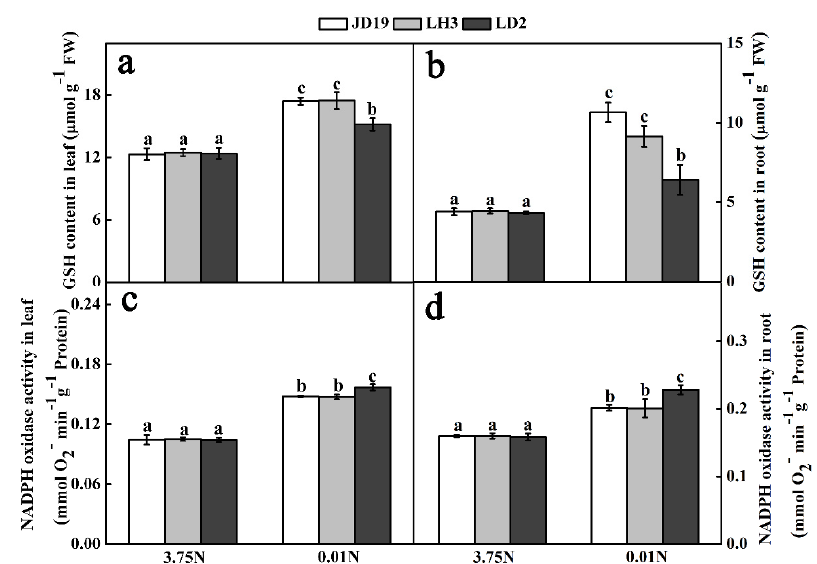
Figure 5. Effects of GSH content and PM NADPH oxidase activity in three soybean cultivars under low-N stress. ( a ) GSH content ( c ) PM NADPH oxidase activity in the leaves ( b ) GSH content ( d ) PM NADPH oxidase activity in the roots. Data are means ± SE ( n = 3, p < 0.05). The letters show significant differences under N conditions.